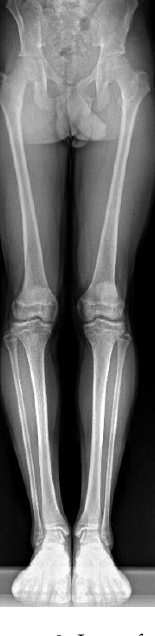
Figure 10. A 6-month post-op MRI scan showing no signs of relapse of the OO. ( a ) Frontal projection; ( b ) Transverse projection. 10. Discussion Our case was interesting due to the fact that we used conventional 2D C-arm radio- graphic guidance for targeting the OO, which has not been previously reported in the studied literature (other authors used 3D C-arm imaging [37,47]. This was partially due to a mechanical failure of the O-arm device that we had originally planned to use. How- ever, considering the many years of our experience with C-arm guidance for treating var- ious spinal lesions (e.g., vertebral fractures, metastases, hemangiomas, etc.), we deter- mined this type of navigation to be safe. No complications were encountered during the procedure. On the contrary, in terms of accuracy, we cannot argue with the fact that CT/O- arm/3D C-arm types of guidance are superior methods to the conventional 2D C-arm. The possible risks of the “imperfect” 3D visualization of the lesion are mainly missing the cen- ter of the tumor and thus its incomplete removal, which can lead to greater risk of a re- lapse. A higher radiation exposure can also occur, mainly when localizing the lesion in separate planes is difficult, and so more radiographs must be taken. Many authors have stated that RFA should still be considered the gold standard in the minimally invasive treatment of OO. The method has been thoroughly tested through the years, and it has